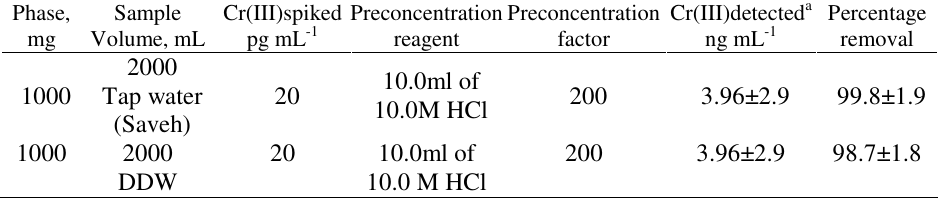
Table 4 . Preconcentration of Cr(III) from DDW and natural tap water samples a